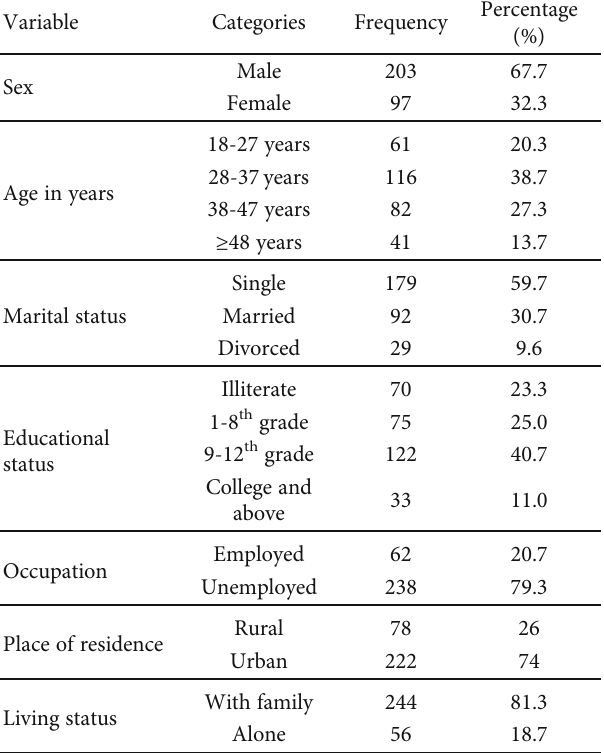
Table 1: Sociodemographic characteristics of PWS at AMSH, 2019 ð n = 300 Þ .